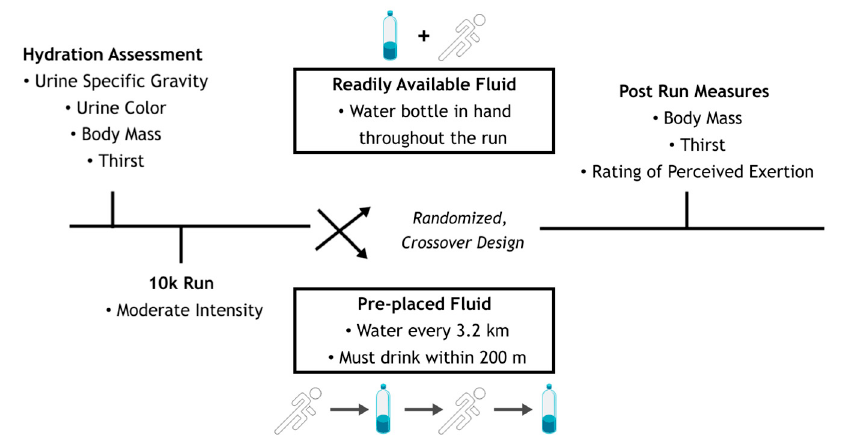
Figure 1. Fluid availability study design.